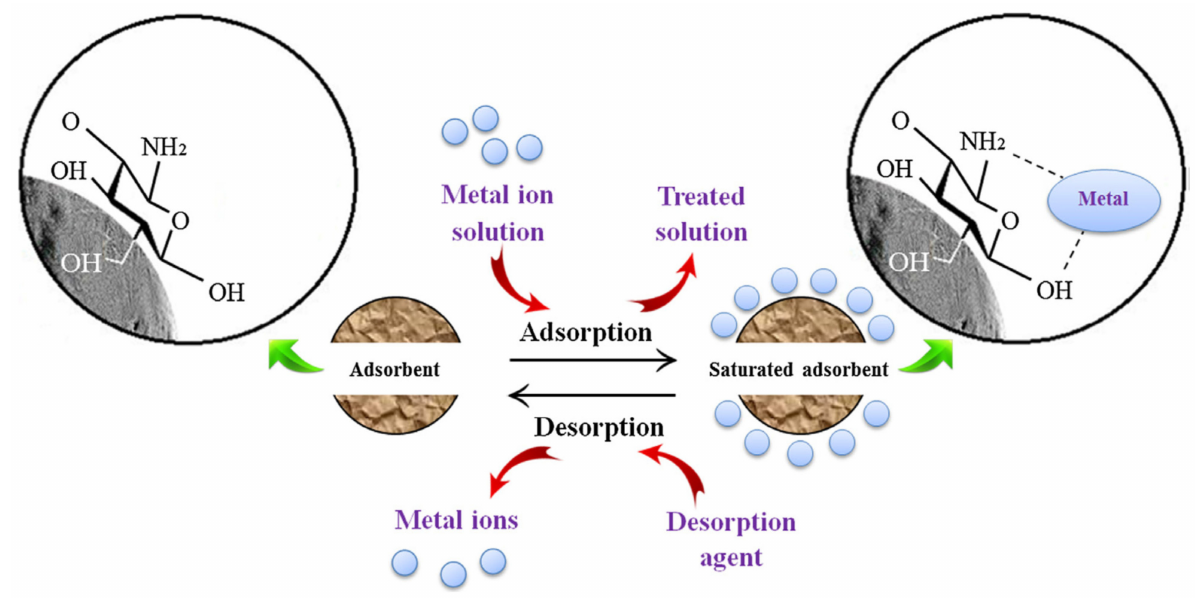
Figure 3. Schematic representation of regeneration procedure of chitosan adsorbent. Reproduced with permission from